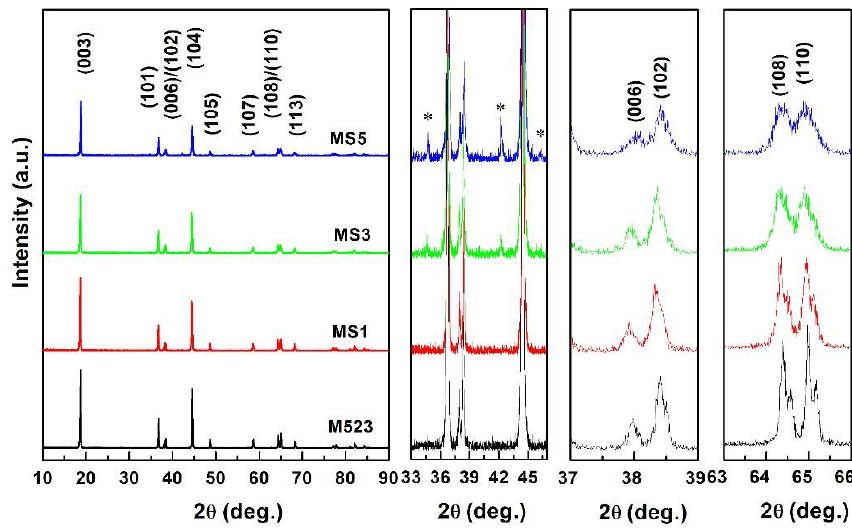
Figure 1. XRD patterns of Sn-modified LiNi 0.5 Co 0.2 Mn 0.3 O 2 samples ( ∗ represents Li 2 SnO 3 ). Table 1. Lattice constants of Sn-modified LiNi 0.5 Co 0.2 Mn 0.3 O 2 samples.